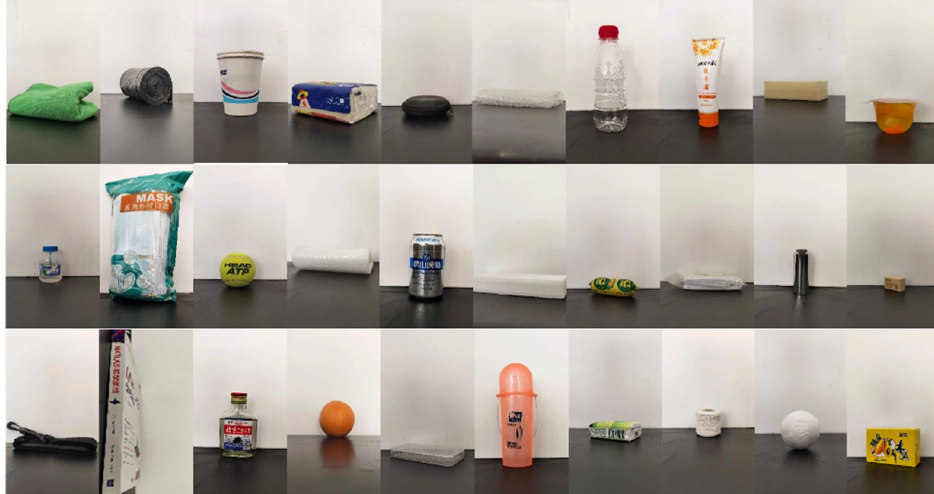
Figure 3. A total of 30 objects in the NumaTac haptic data set (from left to right and from top to bottom; the objects are a towel, garbage bag, paper cup, medium draw paper, earphone box, bubble wrap, mineral water bottle, hand cream, square sponge, jelly, glue, mask, tennis, double layer foam, can, square foam, ham sausage, triangular bandage, metal column, rubber, black bandage, book, glass bottle, orange, plastic box, dental cylinder box, small draw paper, white thread group, foam ball, and soap box).